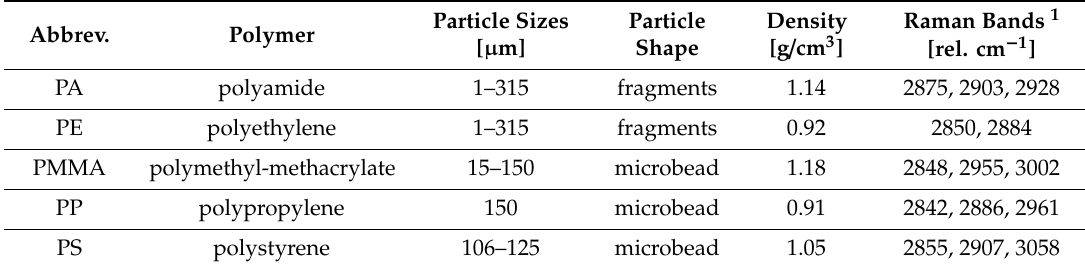
Table 1. Microplastic sample